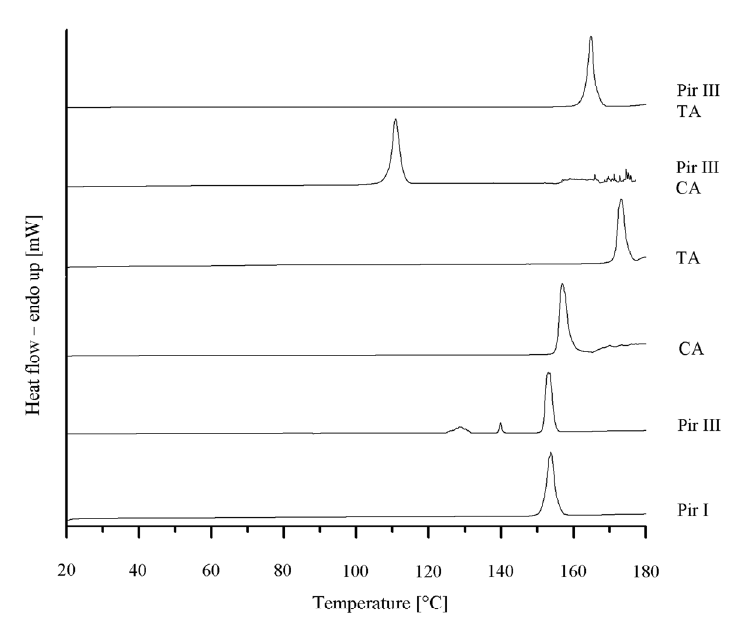
Figure 4. DSC thermograms of piracetam form I (Pir I) and form III (Pir III), citric acid (CA), tartaric acid (TA), piracetam-citric acid cocrystal(Pir III CA), and piracetam-tartaric acid cocrystal (Pir III